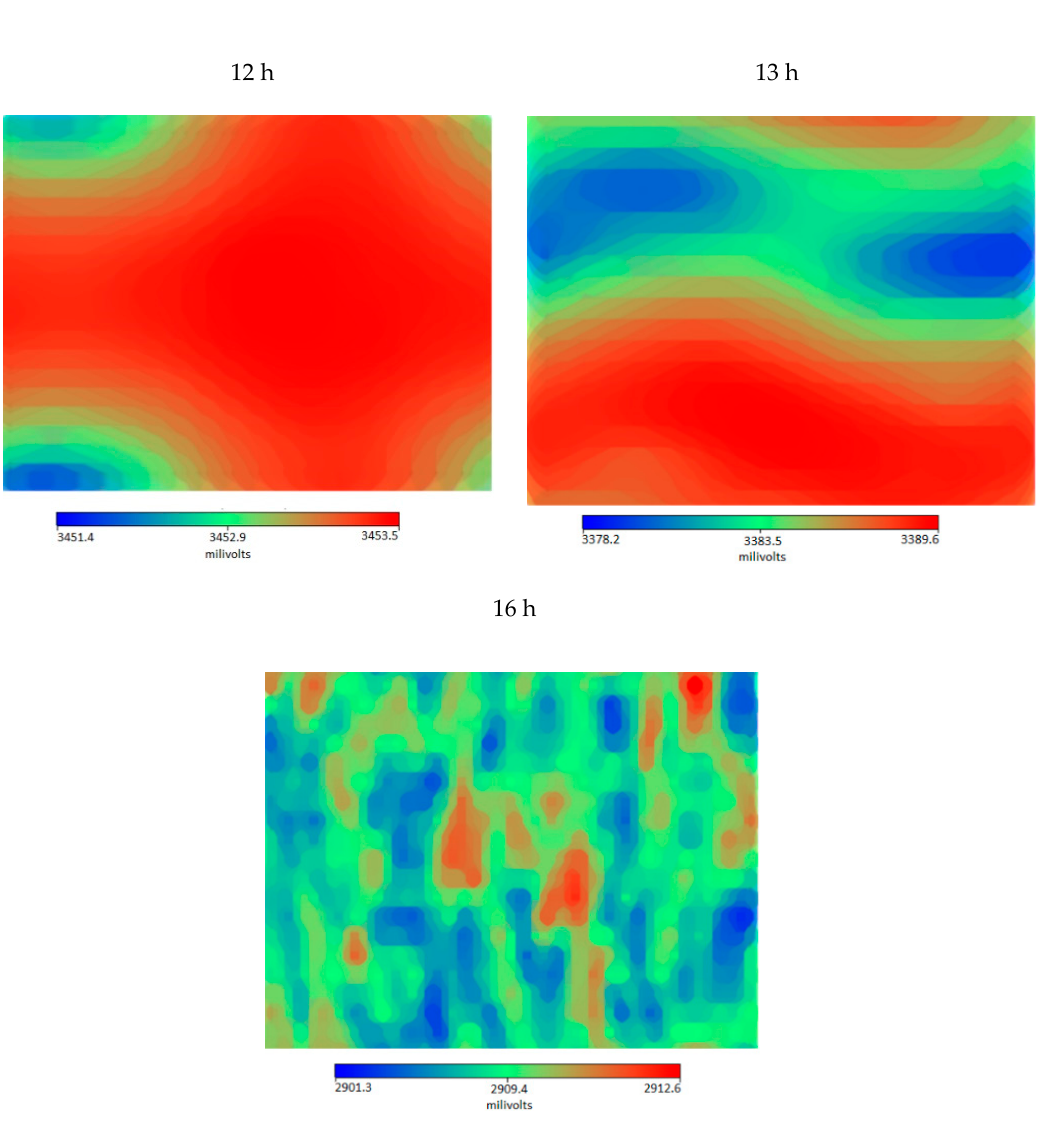
Figure 5. Surface potential images (2 × 2 μ m 2 ) of G4-F nanoaggregate samples after different irradiation times.